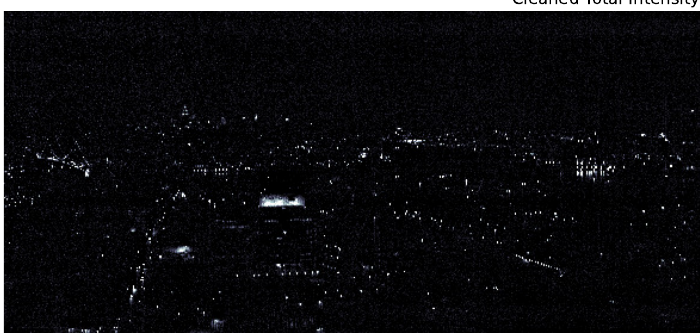
Figure 2. A night time version of the same scene as Figure 1 integrated from 0.4–1.0 µ m.